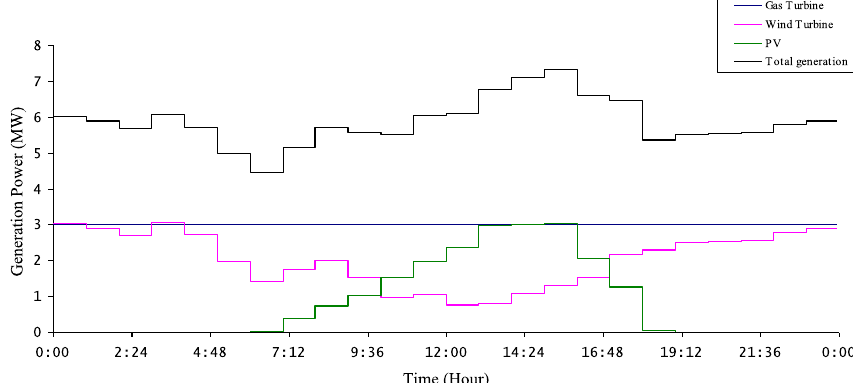
Fig. 5 Daily generation curves of microgrid example